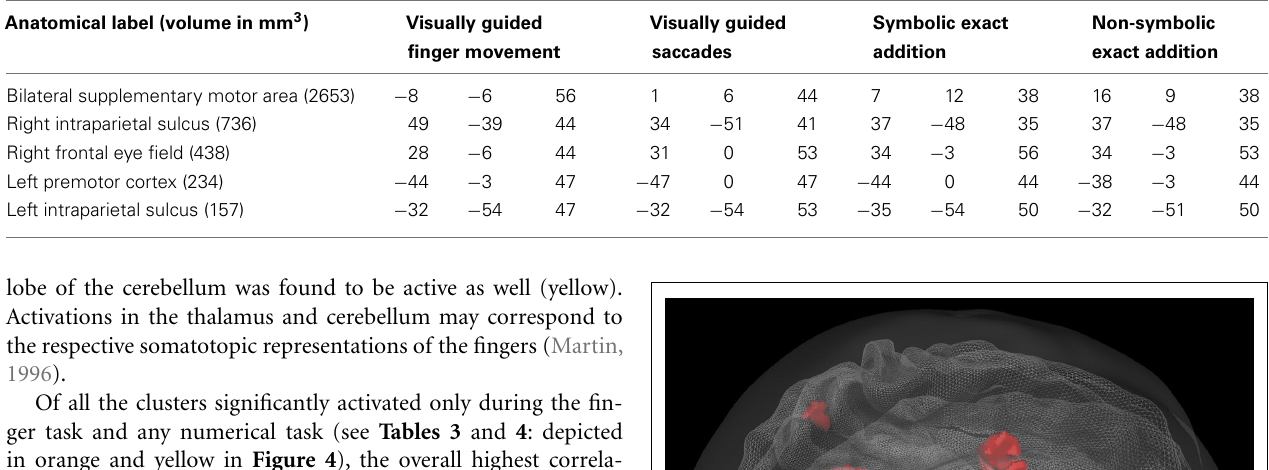
Table 6 |Anatomical labels and volumes in cubic millimeter of clusters significantly in the visually guided finger movement and saccades tasks as well as in the symbolic and the non-symbolic exact addition tasks, but not in the symbolic and non-symbolic magnitude comparison tasks (depicted in blue in Figure 3) with respectiveTalairach coordinates ( x y z ) of peak values for all included tasks. Anatomical label (volume in mm 3 ) Visually guided Visually guided finger movement